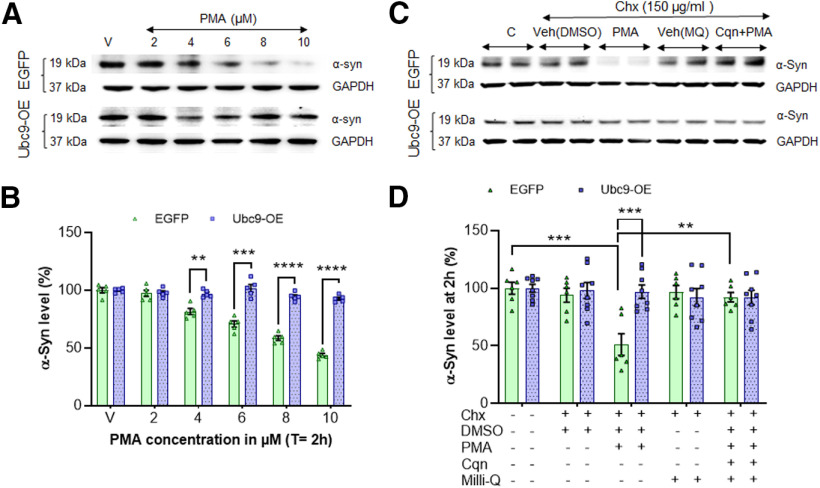
Ubc9 overexpression significantly prevents the PMA-induced lysosomal degradation of α-syn in 2-h protein degradation analysis. A, In WBs, the level of α-syn in N27-EGFP cells declines in the dosage-dependent manner of PMA treatment in 2-h chase study, while that in Ubc9-OE cells remains the same. B, In the integrated density analysis of WB images, Ubc9-OE significantly prevents PMA-induced degradation of α-syn even at 10 μm PMA (n = 5). C, After the optimization of PMA and Chx at various concentrations, 5 μm PMA and 150 μg/ml of Chx were applied to EGFP and Ubc9 cells for WBs. D, In the integrated density analysis of WB images, PMA in EGFP cells substantially induces the degradation of α-syn in 24-h chase study, while Ubc9 overexpression prevents the PMA-induced lysosomal degradation of α-syn. No treatment control (C) was considered as 100% in the relative ratio of α-syn/GAPDH and DMSO was vehicle for PMA treatment. The second vehicle for the PMA inhibitor, chloroquine (Cqn) was distilled water (MQ, Milli-Q H2O), which was included as well as Cqn+PMA for comparison. The ratio of α-syn/GAPDH was presented in mean ± SEM in % of control (n = 5–8 per treatment). Statistical analysis was performed by using two-way ANOVA to assess the interaction between Ubc9 and PMA; **p <0.01, ***p < 0.001, ****p < 0.0001.